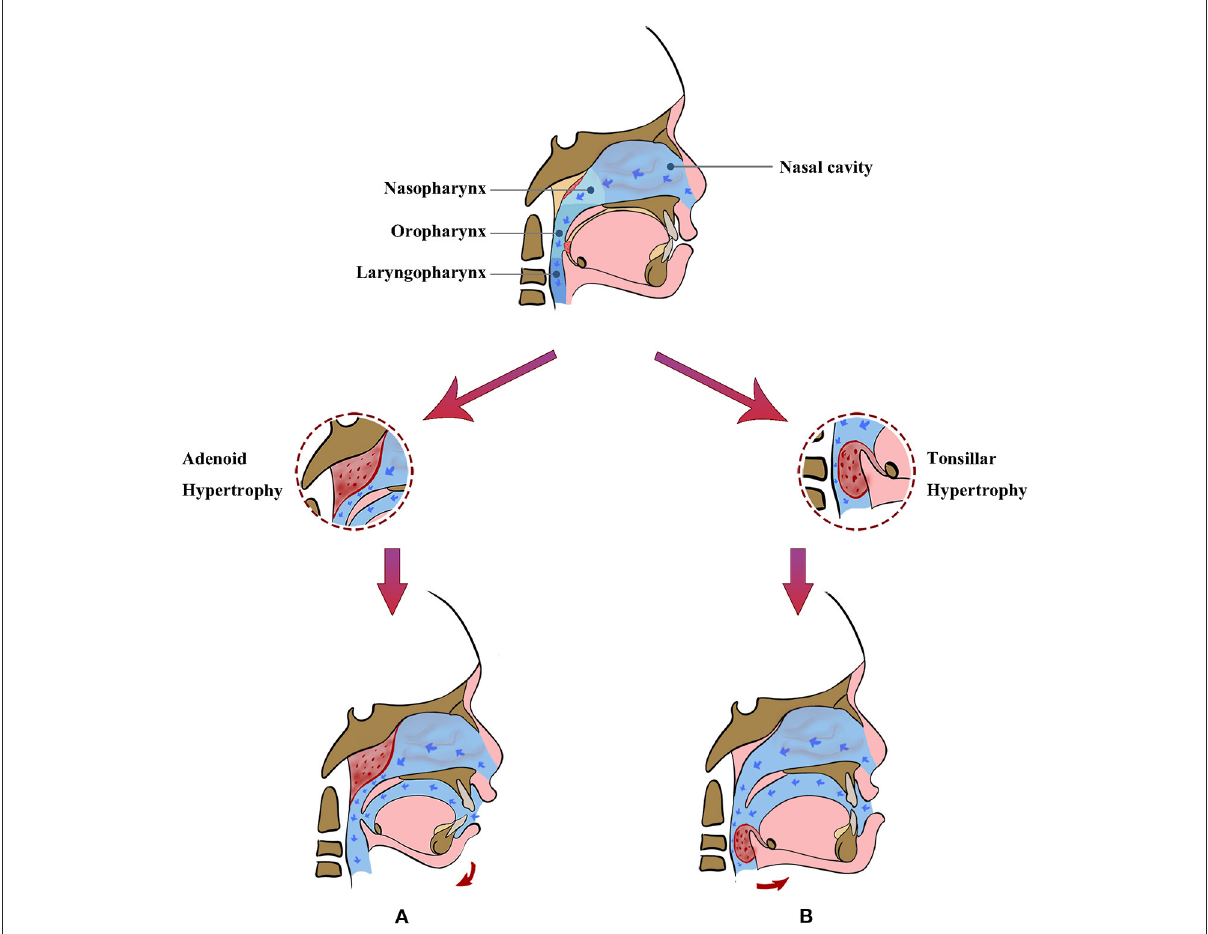
FIGURE1 Mouth breathing resulted from adenoid hypertrophy or tonsillar hypertrophy may have different impact on dentofacial development in children. (A) Adenoid hypertrophy may lead to Class II malocclusion with an increased overjet and clockwise rotated mandible. (B) Tonsillar hypertrophy may result in mandibular protrusion, Class III malocclusion, and a tendency of anterior teeth